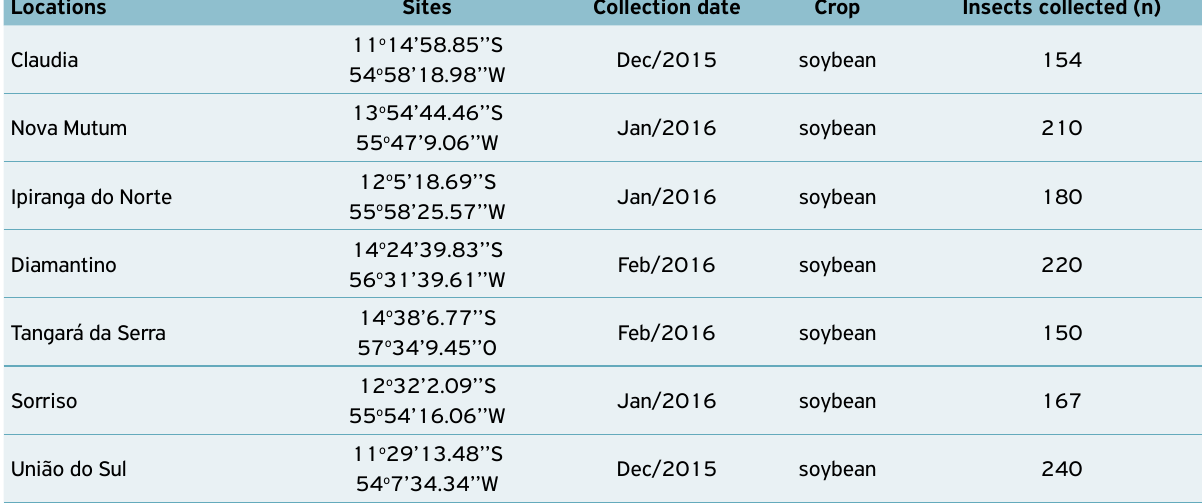
Table 1. Locations, sampling sites, dates, host plant, number of insects collected of Chrysodeixis includens in Mato Grosso.